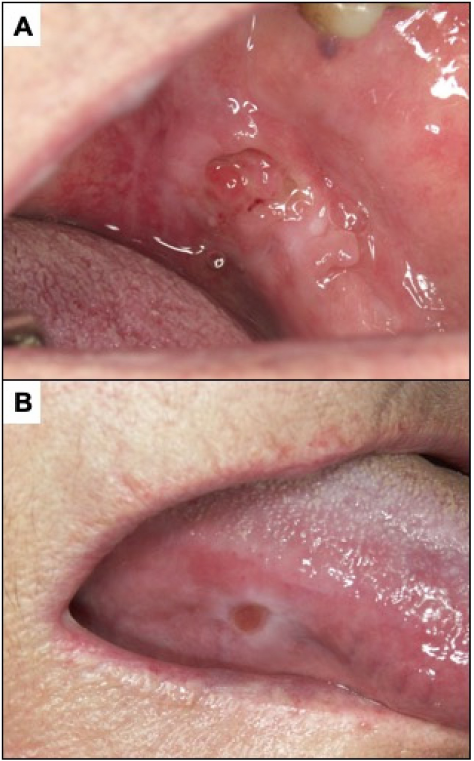
Figure 6. ( A ). Ulcerated incipient oral carcinoma. ( B ). Benign traumatic ulcer. The characteristics of this ulcer should be noted. Clean and homogeneous bottom, well-defined border, white peri- ulcerous halo.